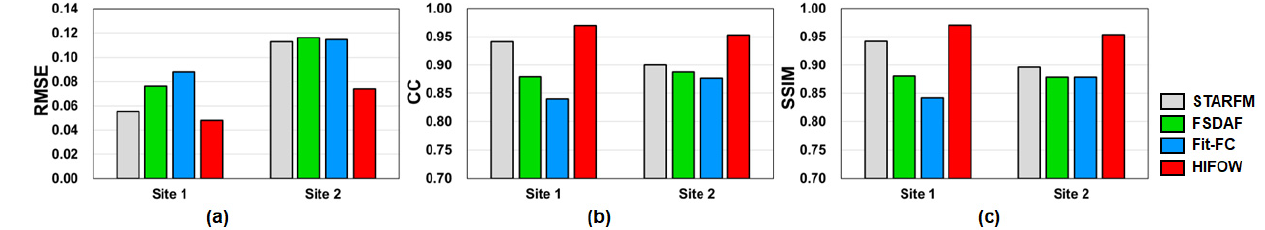
Figure 11. Accuracy statistics of the NDVI prediction results for different STIF models at both sites: ( a ) RMSE; ( b ) CC; and ( c ) SSIM.